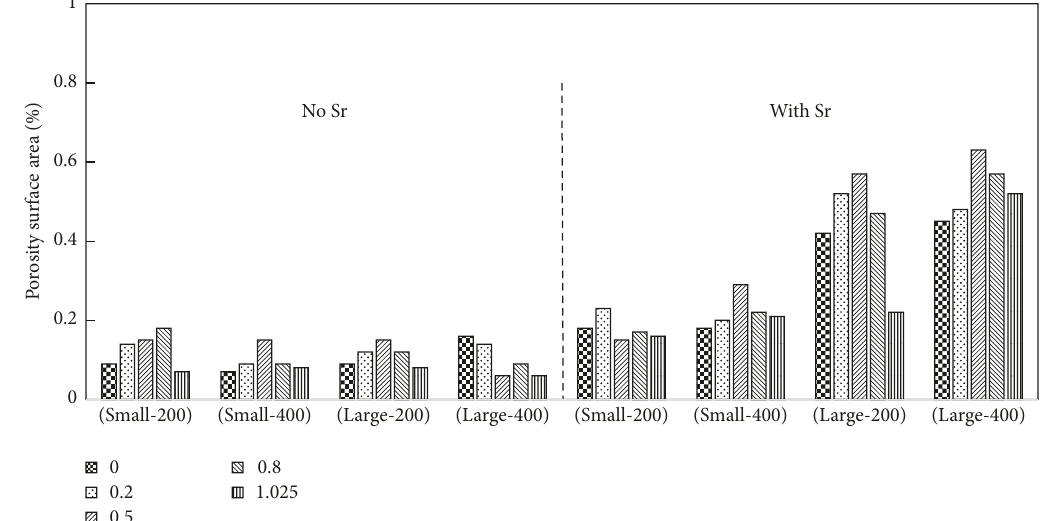
(a) Variation in surface area percentage porosity as a function of La content and casting/solidification condition of the A356 alloy samples (legend at the top center indicates the La level of the samples)